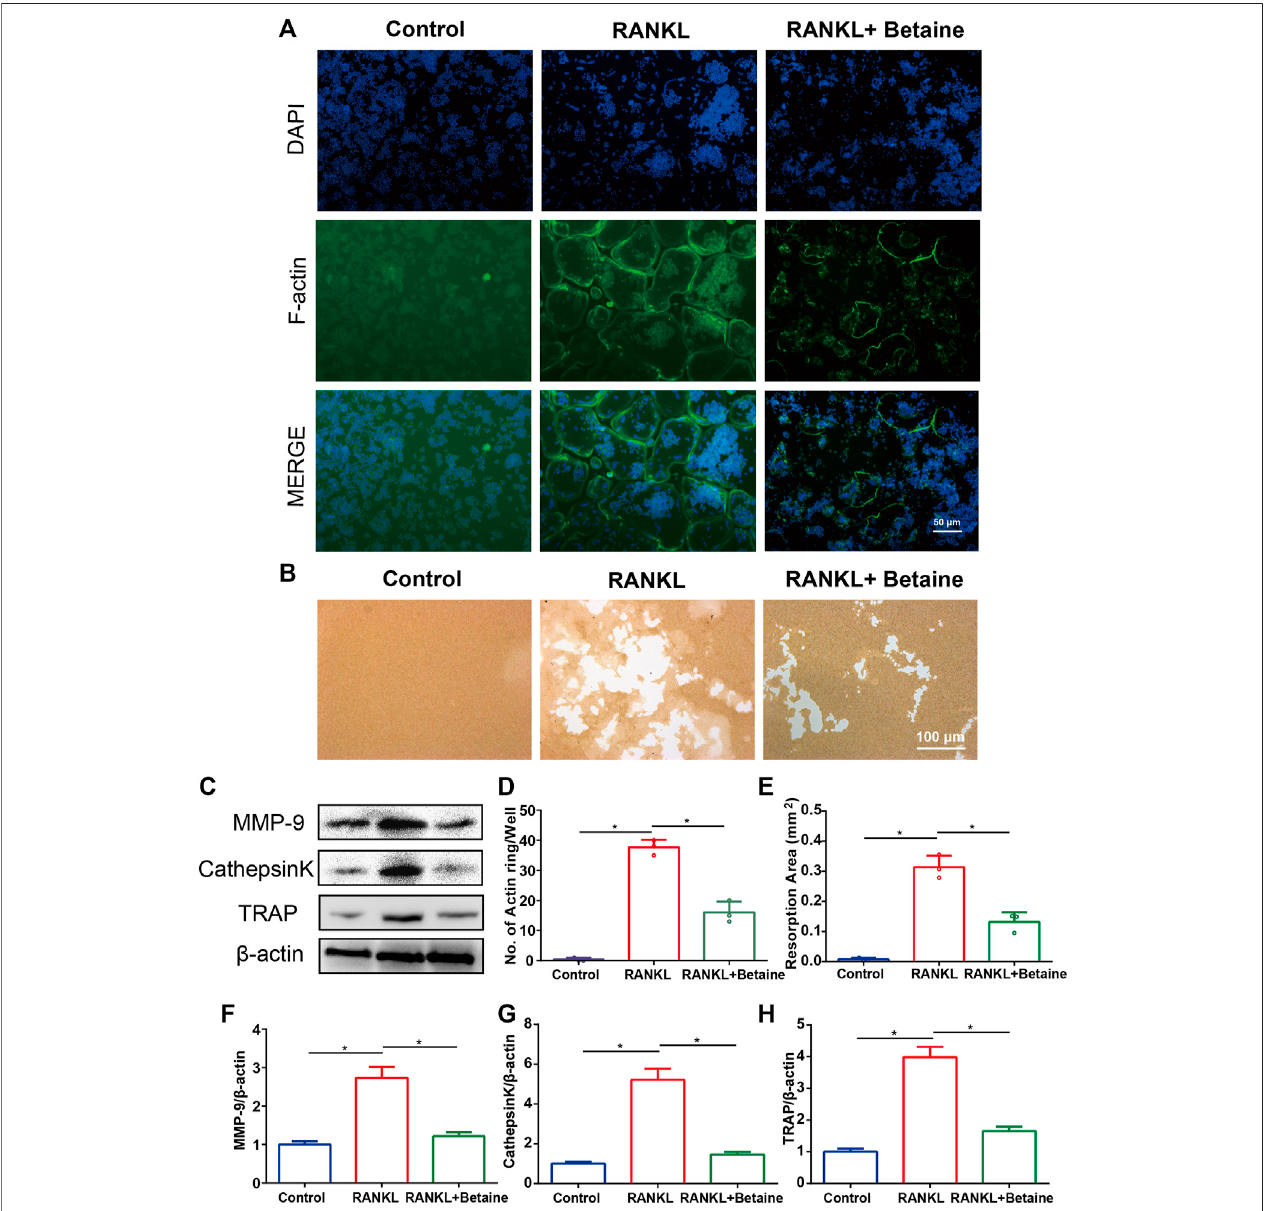
FIGURE 2 | Betaine inhibits osteoclasts function in vitro . (A) F-actin ring formation of osteoclasts. Scale bar, 50 μ m. (B) Pit form assay of osteoclasts. Scale bar, 100 μ m. (C) Western blot of the expression of MMP-9, CathepsinK and TRAP. (D) Quanti fi cation of F-actin ring formation. (E) Quanti fi cation of pits area. (F – H) Quanti fi cation of MMP-9, CathepsinK and TRAP in different groups. * p < 0.05 as denoted by bar, ** p < 0.01 as denoted by bar, *** p < 0.001 as denoted by bar.